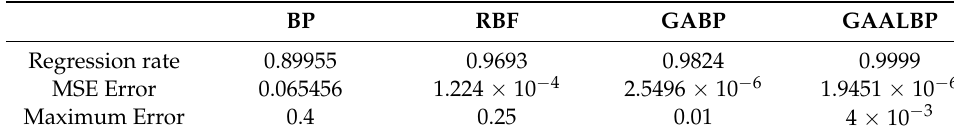
Table 5. Comparison of prediction errors of different networks.